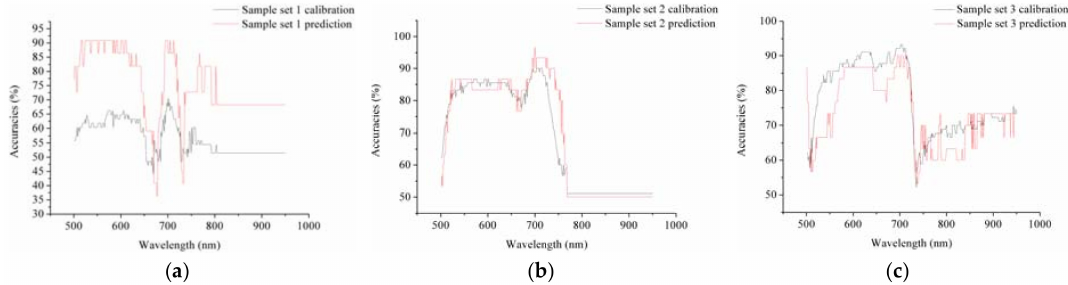
Figure 3. The discriminant results of the SVM models using a single wavelength band of sample set 1 ( a ); set 2 ( b ); and set 3 ( c ).